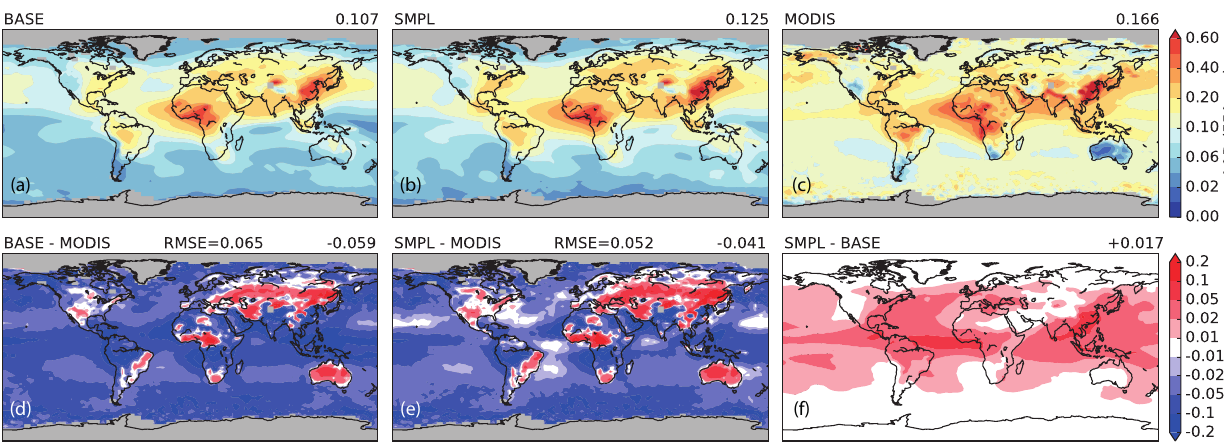
Figure 9. Mean column-average AOD in (a) the BASE simulation, (b) SMPL simulation and (c) observed by MODIS in the period March 2005–February 2006. The resulting difference in AOD between (d) BASE and MODIS, (e) SMPL and MODIS and (f) SMPL and BASE. The numbers above the top right corners are area-weighted global mean AOD. Model values are sampled only for months and locations with valid MODIS